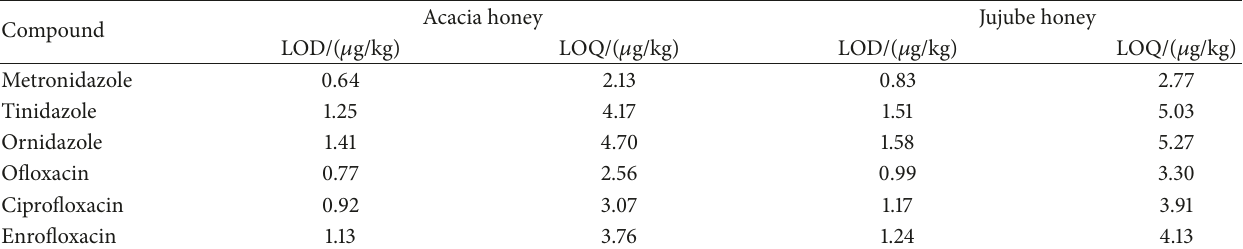
Table 4: LODs and LOQs for the target compounds.